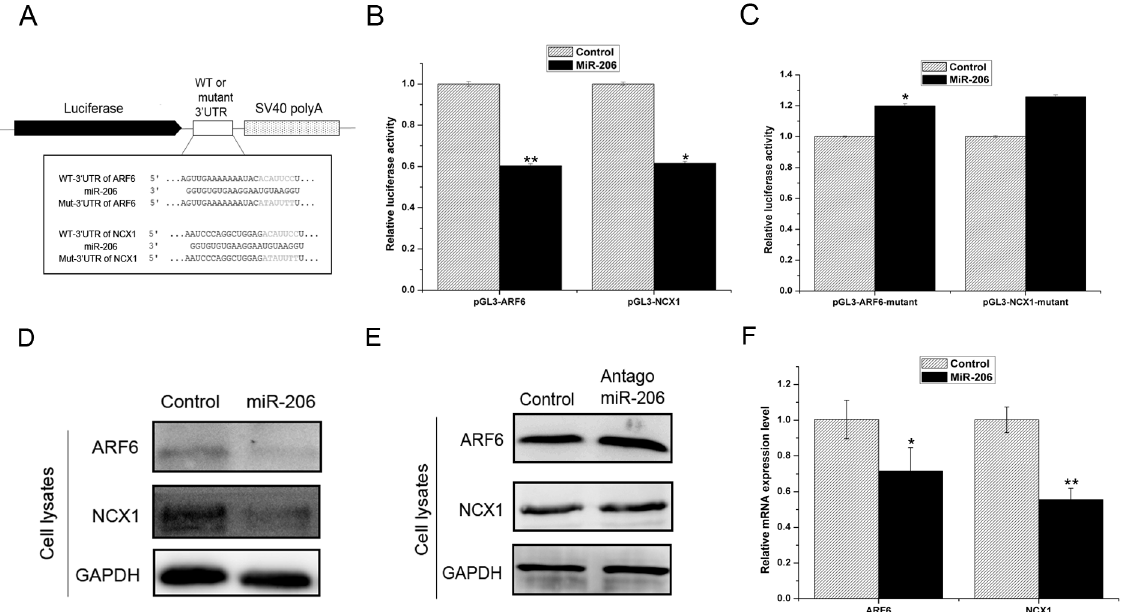
Fig 3. MiR-206 post-transcriptionally controls ARF6 and NCX1 expression. (A) Illustration of the construction of pGL3 vectors containing either the wild- type or mutant 3 ’ UTR of ARF6 and NCX1. (B, C) Measurement of luciferase activity in HeLa cells. (D, E) Western blot analysis of ARF6 and NCX1 protein expression in HUVECs transfected with miR-206 (D) or antagomiR-206 (E). (F) Real-time PCR analysis of ARF6 and NCX1 expression in HUVECs. Three independent experiments were performed for each condition, and the data are presented as the mean ± SEM. * p < 0.05 and ** p < 0.01 versus control